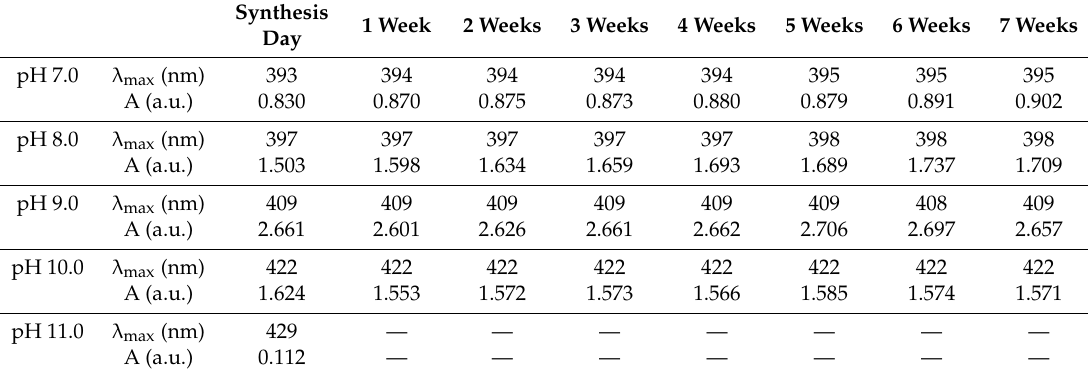
Table 2. Comparison of data on the stability study of colloids reduced by malic acid determined using a UV-Vis spectrometer.